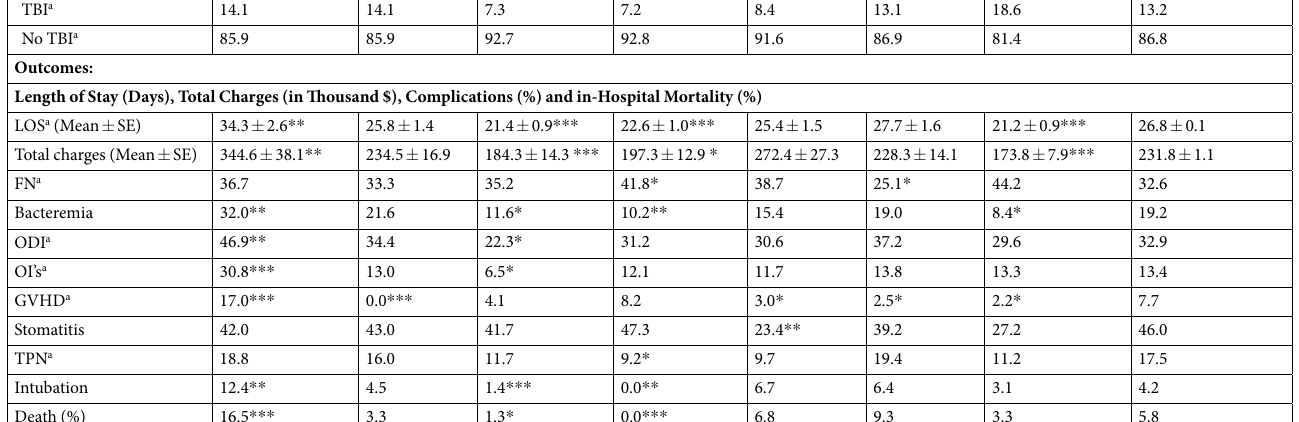
Table 1. Baseline Characteristics and Outcomes in Patients Undergoing HSCT from 1998 to 2011. a Abbreviations: IMID, Immune mediated Inflammatory disease; CCI, Charlson Co-morbidity Index; TBI, Total Body Irradiation; ODI, Other Documented Infections; OI’s, Opportunistic infections; GVHD, Graft-vs.-Host Disease, available after 2007; TPN, Total Parenteral Nutrition; LOS, Length of Stay; FN, Febrile